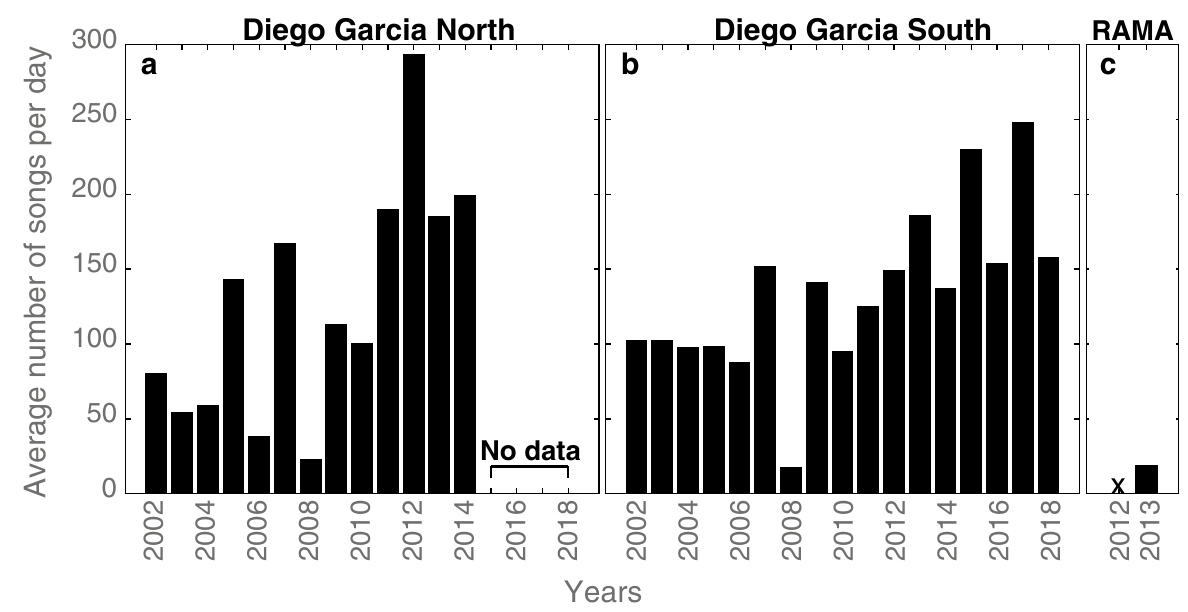
Figure 8. Average number of Chagos songs per day detected in each year of data on the ( a ) western (DGN) and ( b ) eastern (DGS) sides of the Chagos Archipelago, and ( c ) further north-east, at RAMA